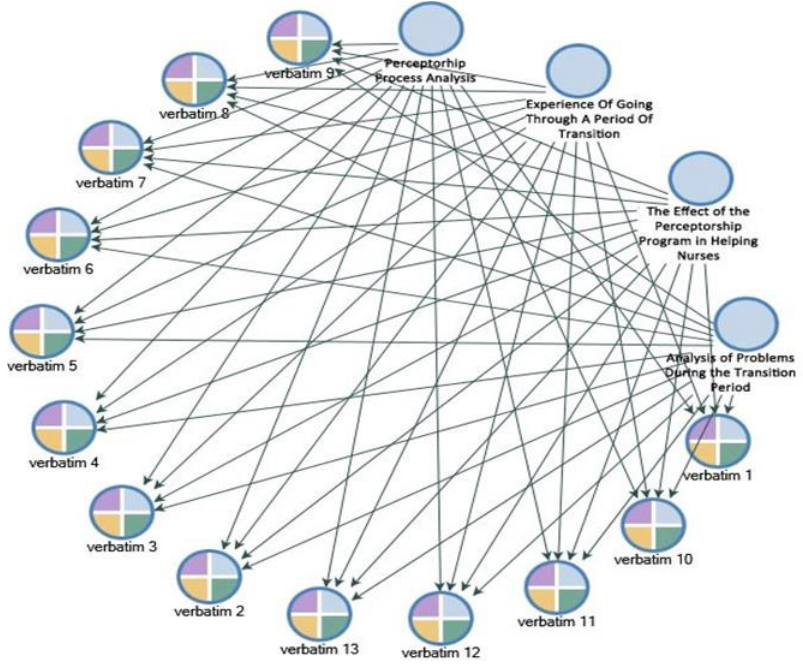
Fig. 7. Distribution scheme of participants' statements on transitional period sub-themes